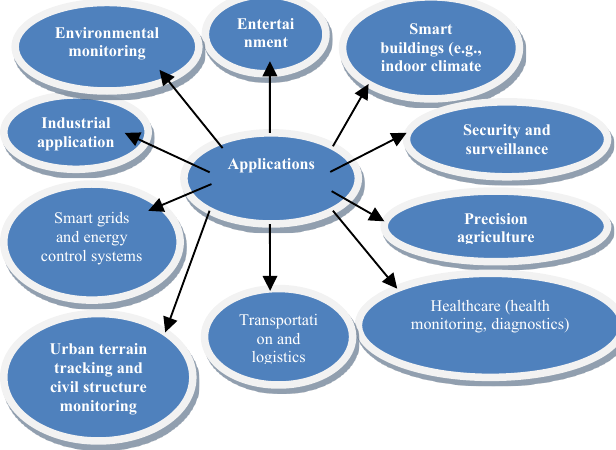
Figure 2. Shows a variety of real-world applications of